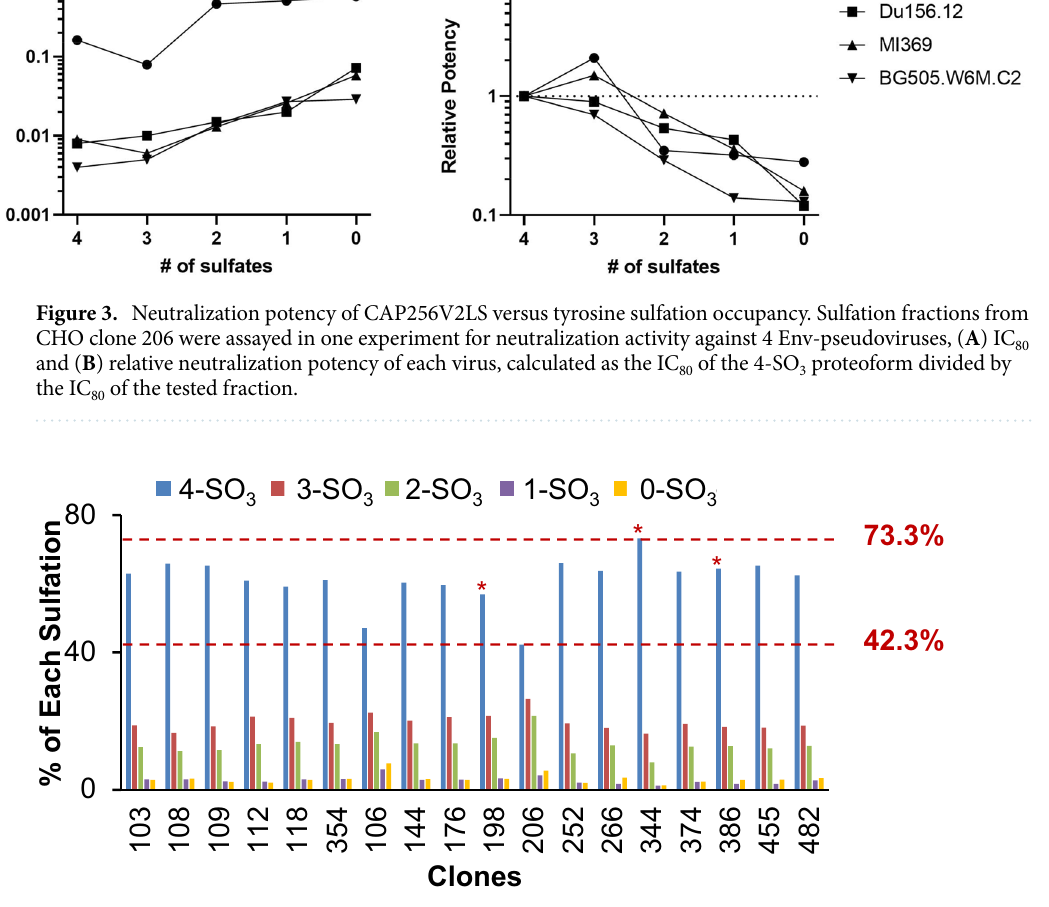
Figure 4. Abundance of CAP256V2LS sulfation proteoforms varied with different CHO cell clones. Sulfation proteoform quantitation of CAP256V2LS expressed from 18 CHO clonal cell lines cultured at 250-ml scale was performed once for each sample. Asterisk marks the three top clones selected for subsequent 3-l scale